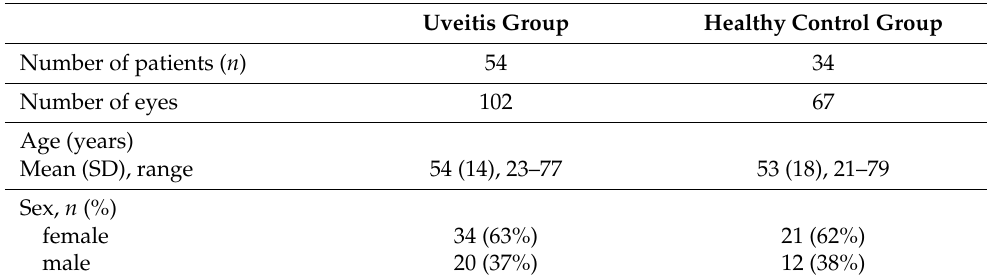
Table 1. Patient’s